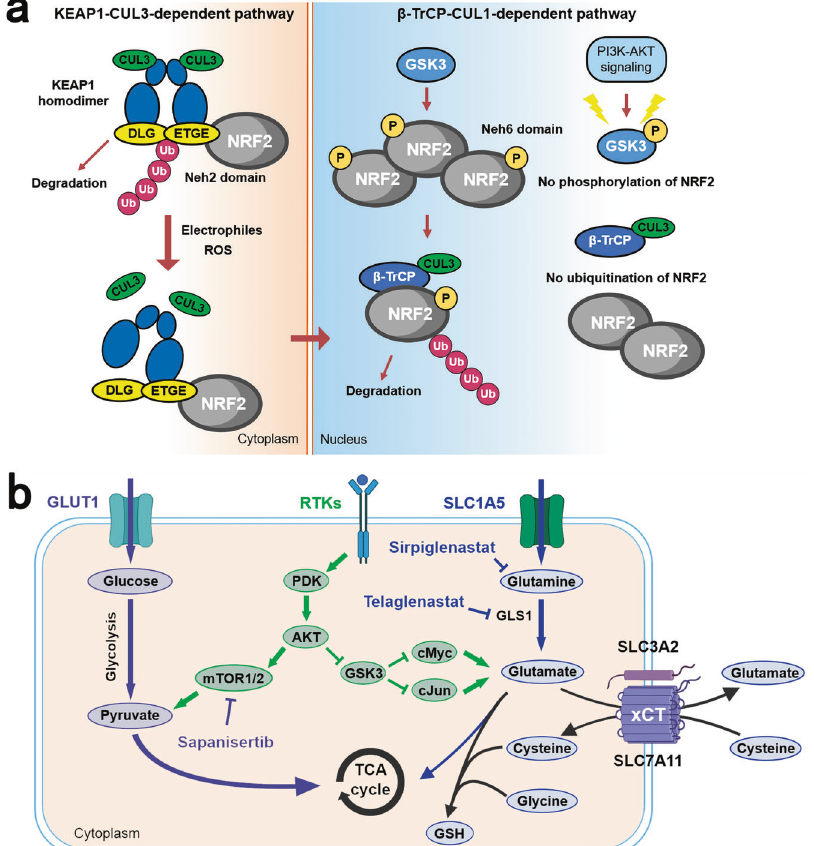
Fig. 3 Physiologic activation and regulation of NRF2 and metabolic reprogramming by NRF2 in LSCC cells. a In unstressed conditions, KEAP1 forms a ubiquitin E3 ligase complex with CULLIN3 (CUL3) and binds with NFR2 via the DLG and ETGE motifs in the Neh2 domain of NRF2 in the cytoplasm. NRF2 is then polyubiquitinated and degraded through the proteasome system after its synthesis. When cells are exposed to electrophiles or ROS, KEAP1 is modi fi ed and the KEAP1-CUL3 ubiquitin E3 ligase activity declines, which stabilizes NRF2. Stabilized and accumulated NRF2 translocates to the nucleus and functions as a transcriptional factor. NRF2 is also regulated through a KEAP1-independent mechanism in which GSK3 plays an important role. NRF2 is phosphorylated by GSK3 and then recognized by β -TrCP. By contrast, the Neh6 domain of NRF2 serves as the degron exploited in this β -TrCP-CUL1-dependent degradation of NRF2. Following its ubiquitination by the β -TrCP-CUL1 E3 ubiquitin ligase complex, NRF2 is degraded by the proteasome. b LSCC cells displayed a dual reliance on glucose